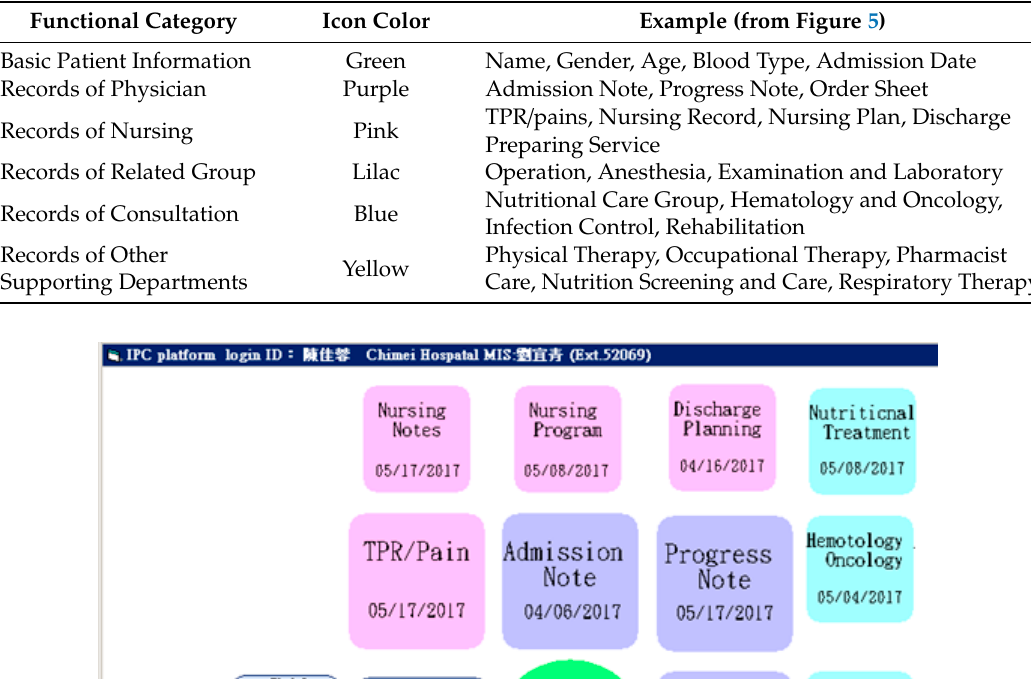
Table 2. The functional categories and their corresponding color.